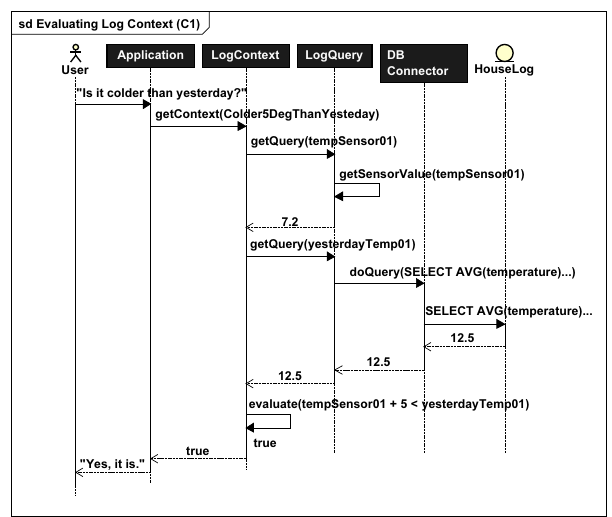
Figure 3. Sequence diagram for evaluating log context (C1) “it is 5 degree colder than yesterday.”